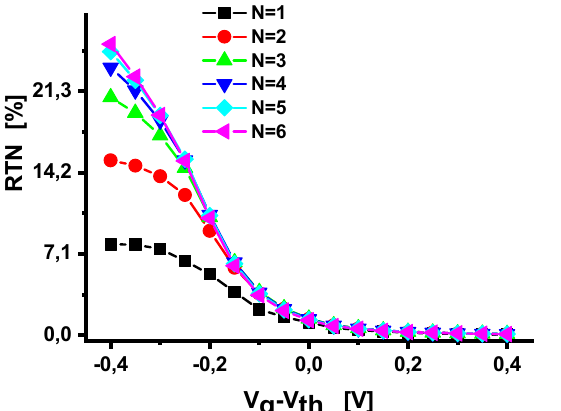
Figure 8. RTN amplitude dependence on the gate overload for different numbers of the single charges trapped N in the defect area.